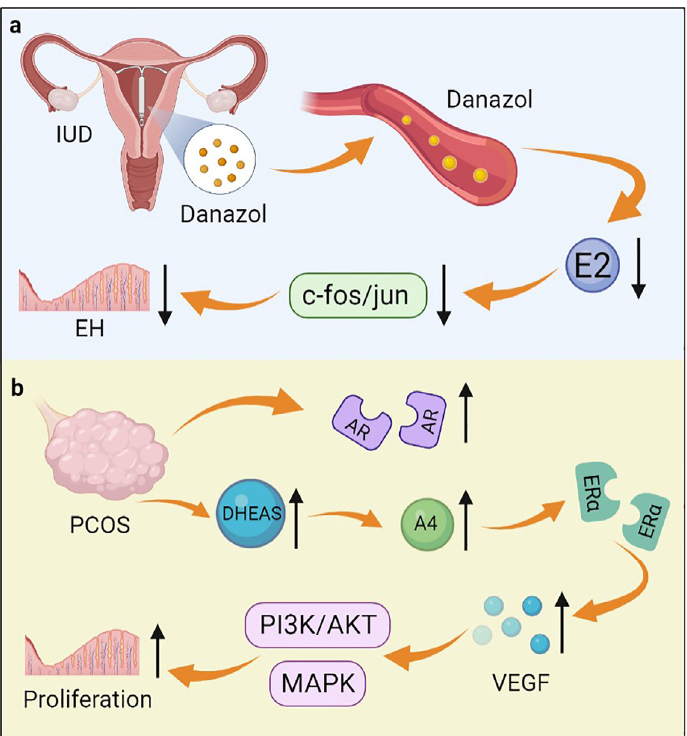
Figure 3. The role of androgen in endometrial hyperplasia. ( a ) An IUD containing danazol inhibits estrogen-induced c-fos/jun expression by releasing danazol, thereby inhibiting endometrial hyper- plasia; ( b ) DHEAS and AR are increased in women with PCOS. DHEAS is converted to A4, which increases the expression of VEGF through ER α . VEGF further activates the MAPK and PI3K/AKT pathways, thereby promoting the occurrence of endometrial